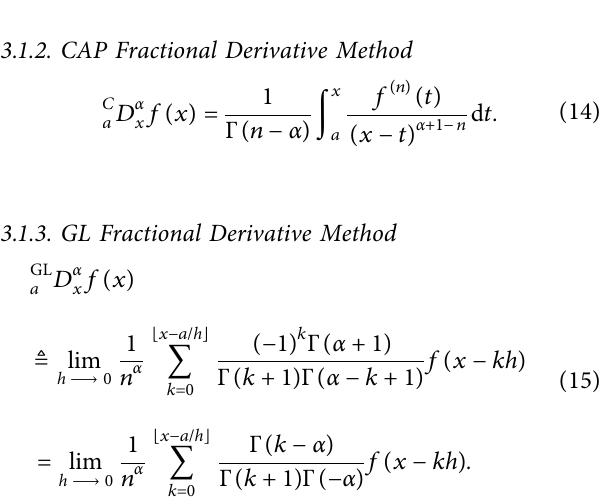
Figure 1: Te irregular sampling